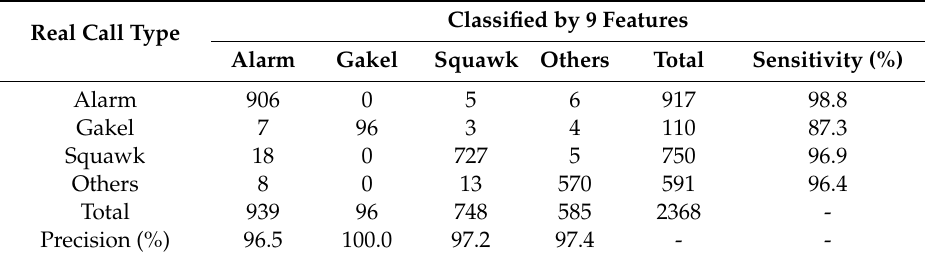
Table 3. Confusion matrix of support vector machine (SVM) modelling.